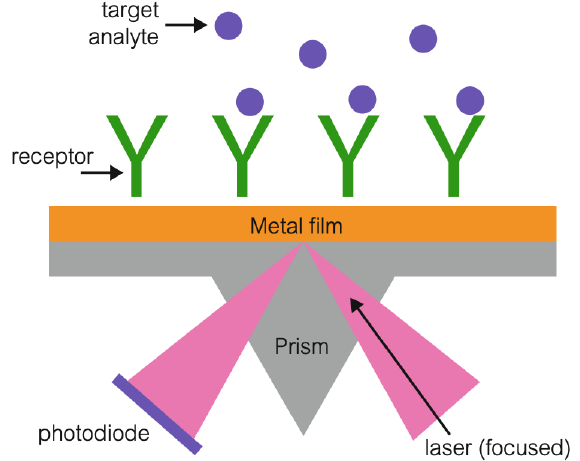
Figure 4: Diagram of the oscillation from excited electrons from electromagnetic